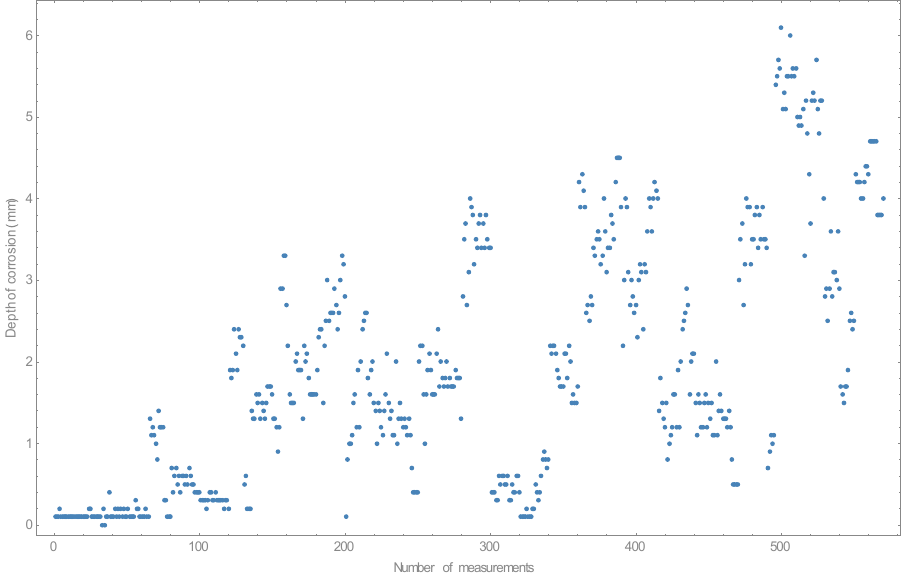
Figure 2. The data of 570 thickness measurements of inner bottom plates obtained through 38 ship surveys.